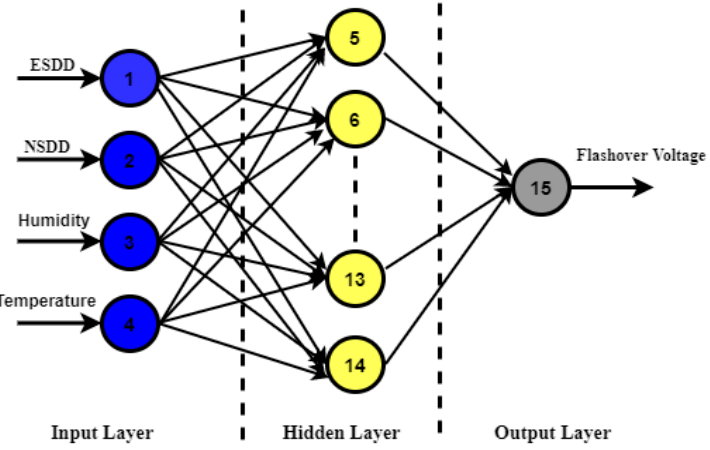
Figure 8. Schematic diagram of the proposed ANN network .